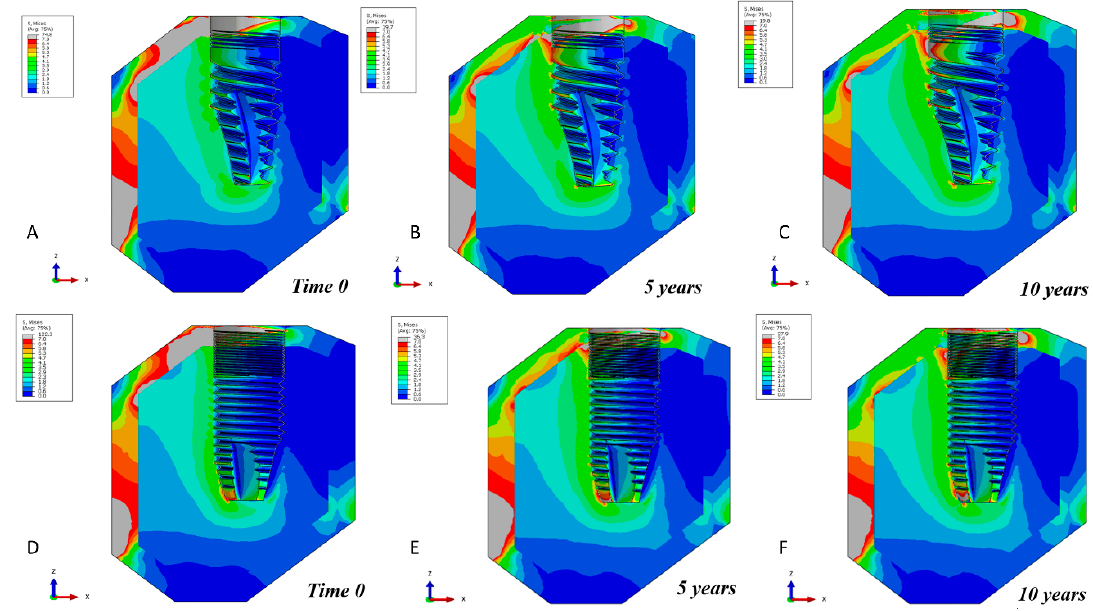
Figure 4. Progress of the maximum stress over the 10-year period for the two implants tested in the present study. M-12 implant ( A – C ). Astra implant ( D – F ).